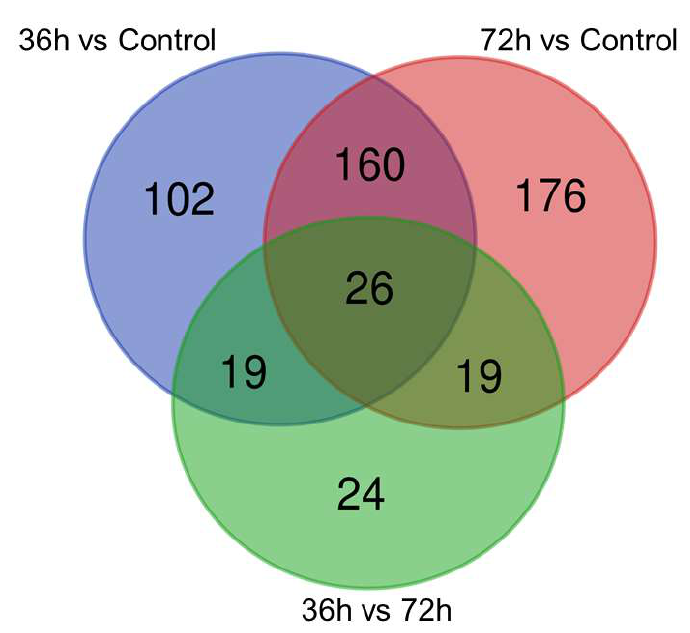
Figure 5. Venn diagram of the altered hemocyte proteome profiles between different time points after the V. parahaemolyticus challenge. The numbers of unique and common differentially expressed proteins between the time points are indicated.